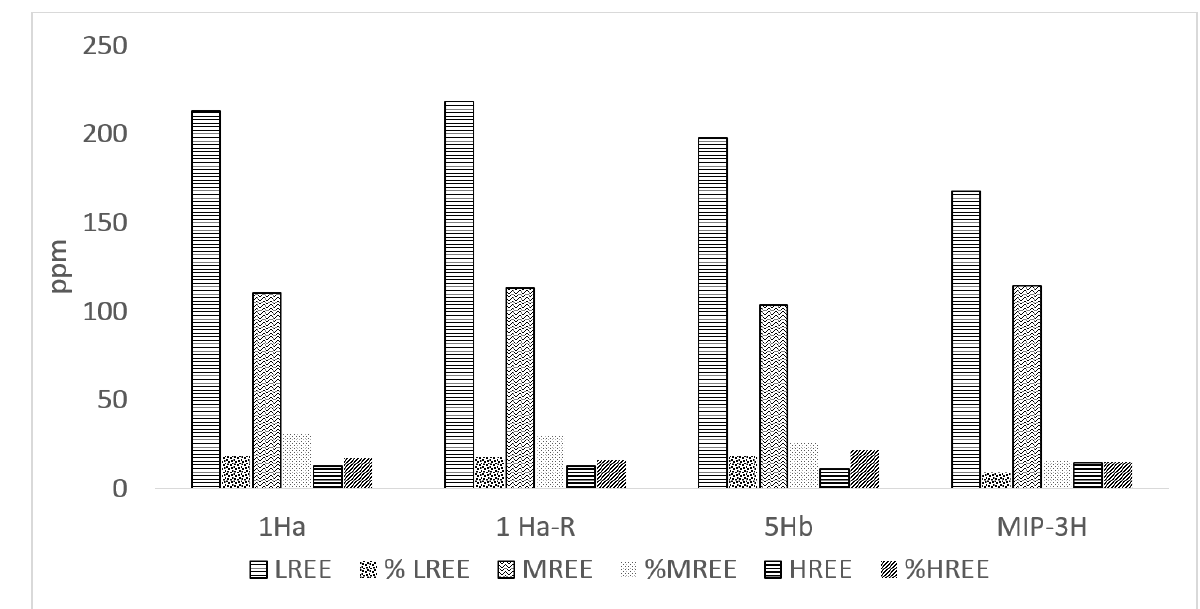
Figure 4. Concentration (in ppm) and percentage of LREE, MREE, and HREE fraction extracted.